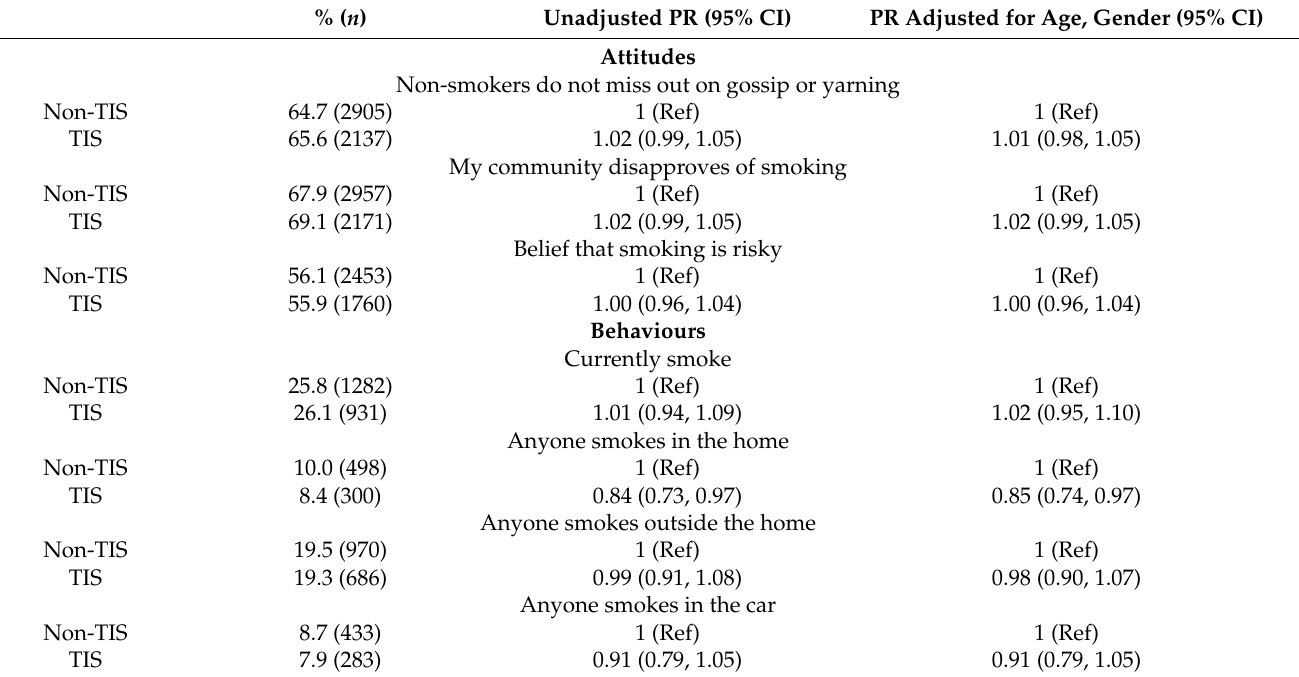
Table 5. Relationships between TIS and smoking-related attitudes and behaviours in the total sample (includes current, past, and never